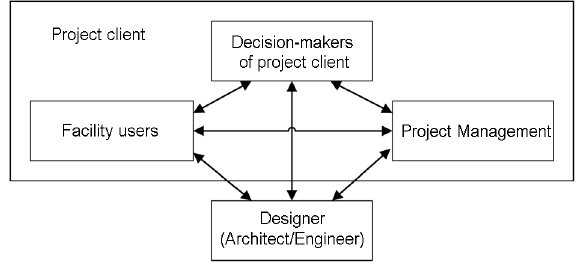
Fig. 2. Interactions among four project participants in the case